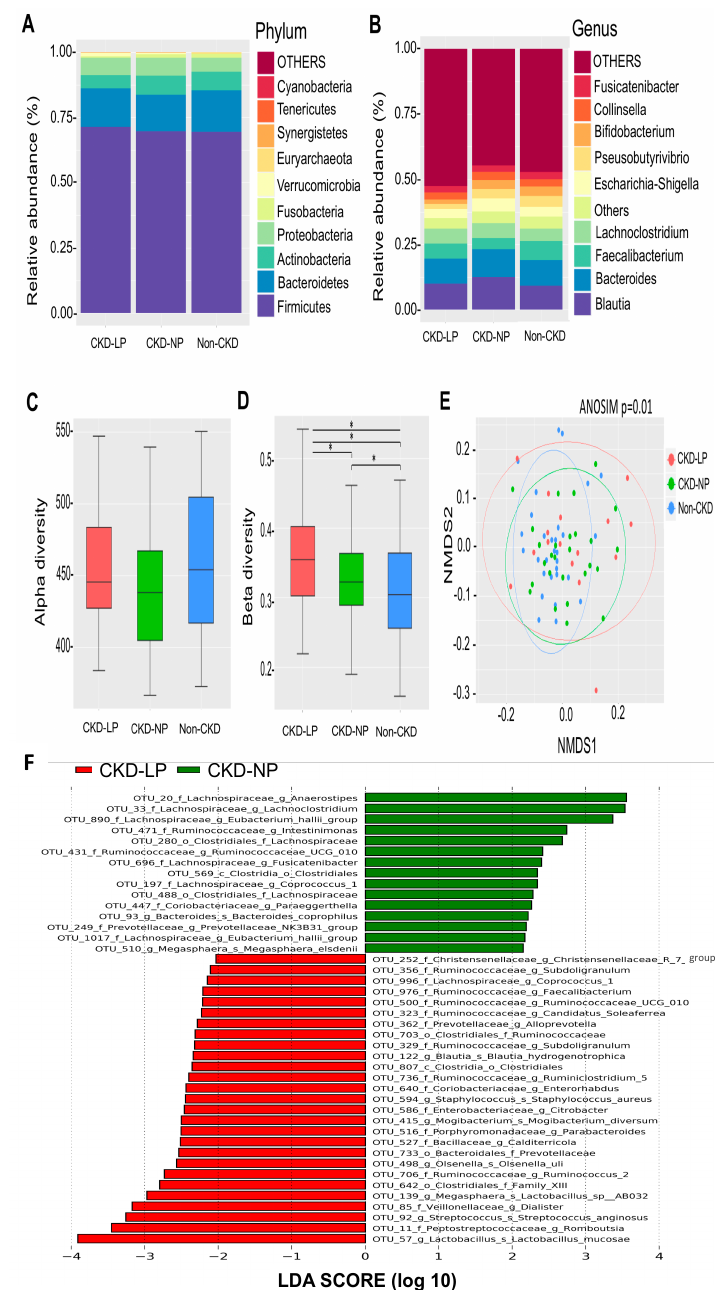
Figure 1. Comparisons of gut microbiota composition and diversity in non-CKD controls and CKD patients receiving LPD or NPD. ( A ) The distribution of top 10 phyla and top 10 genera ( B ) detected among groups. ( C ) α - diversity (Chao 1) and ( D ) β -diversity (Bray–Curtis similarity index) of gut microbial communities among groups. The box-plot shows the median, the 25th, and the 75th percentile in each group. *, p < 0.001 ( E ) Nonmetric multidimensional scaling (NMDS) ordination based on weighted UniFrac parameters of intestinal microbial communities among groups. Significant sample-to-sample dissimilarities refer to analysis of similarity (ANOSIM, p = 0.01) test for discrimination in community composition among groups. ( F ) Bacterial taxa that best characterize each group were determine by applying linear discriminant analysis of e ff ect size (LEfSe) on OTU tables. LP, low protein diet; NP, normal-protein